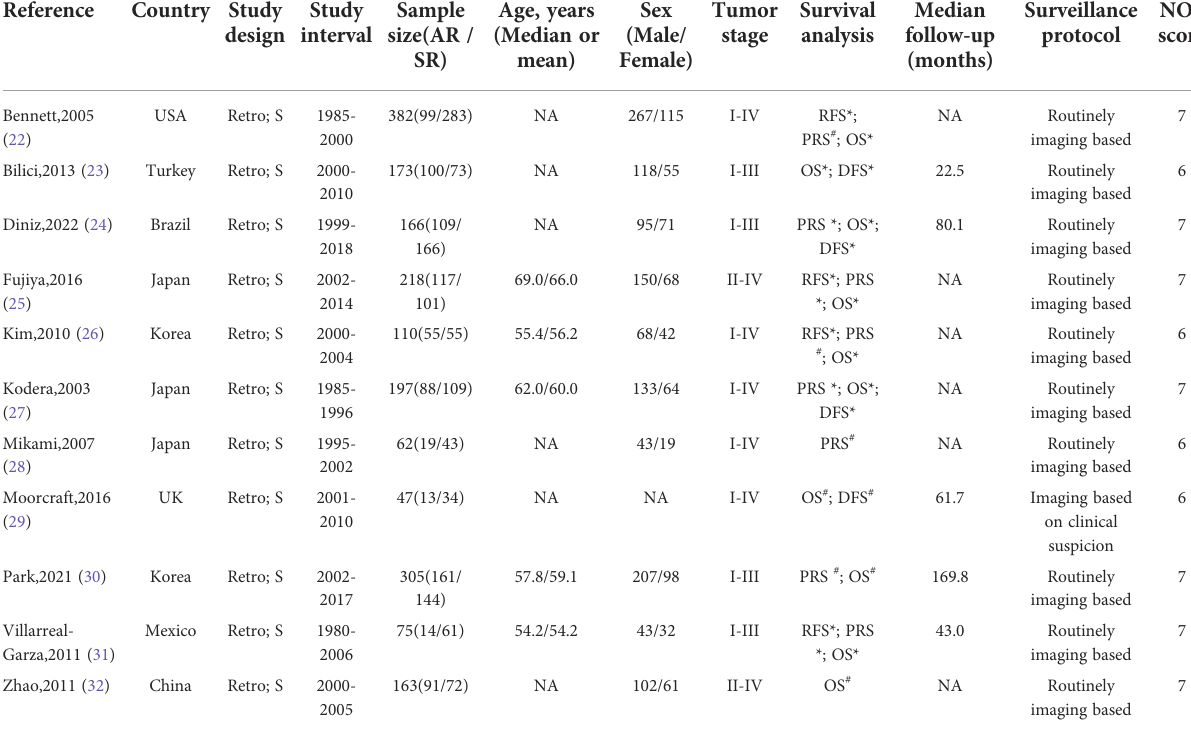
TABLE 1 Basic information of included